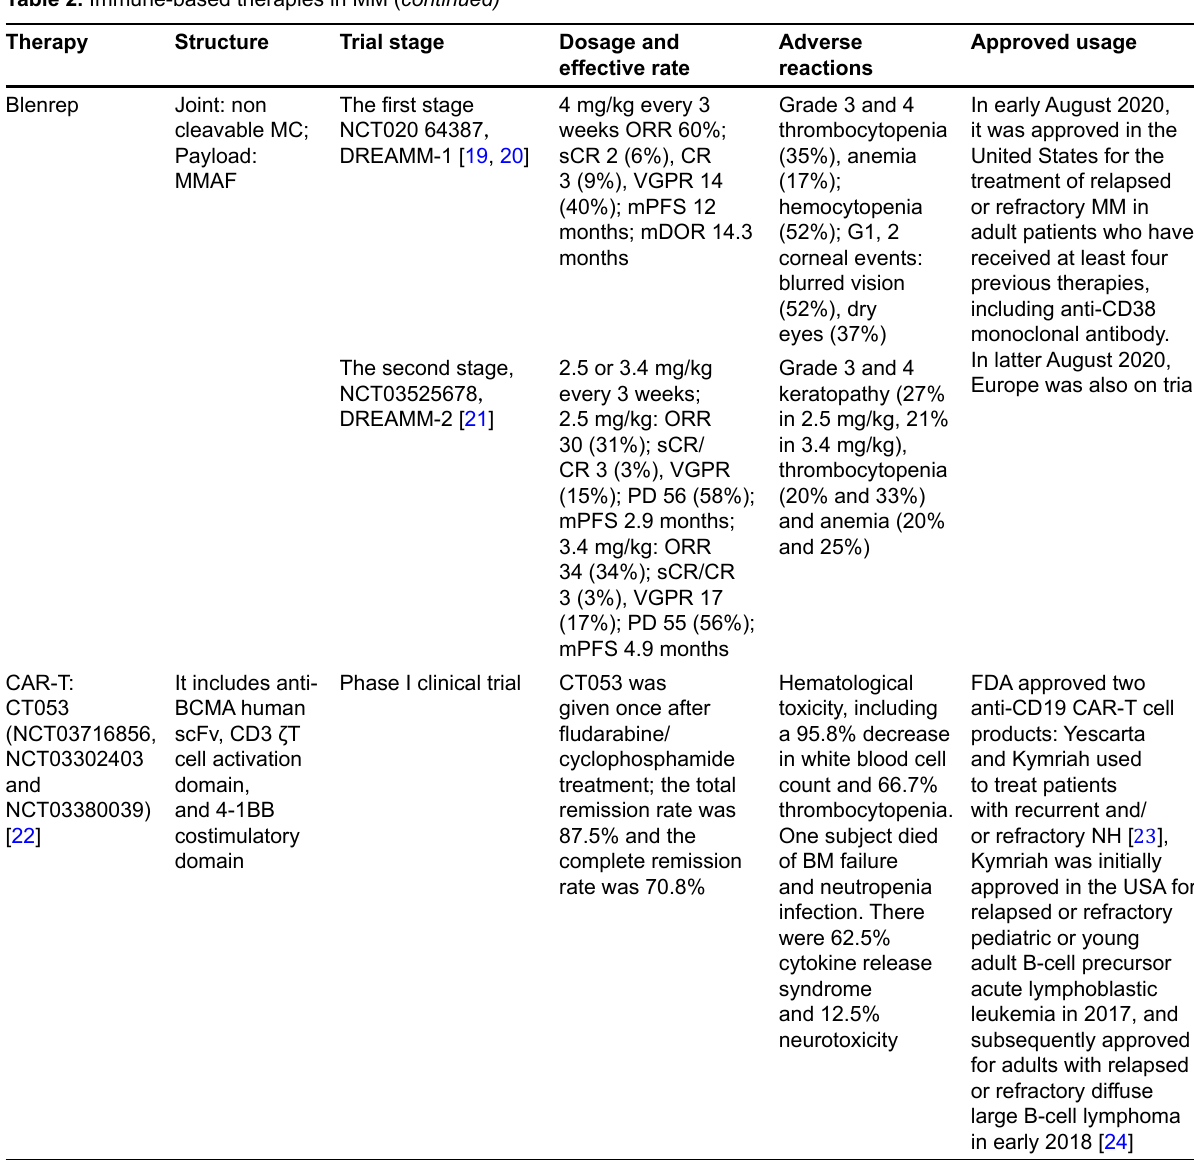
Table 2. Immune-based therapies in MM ( continued) Therapy